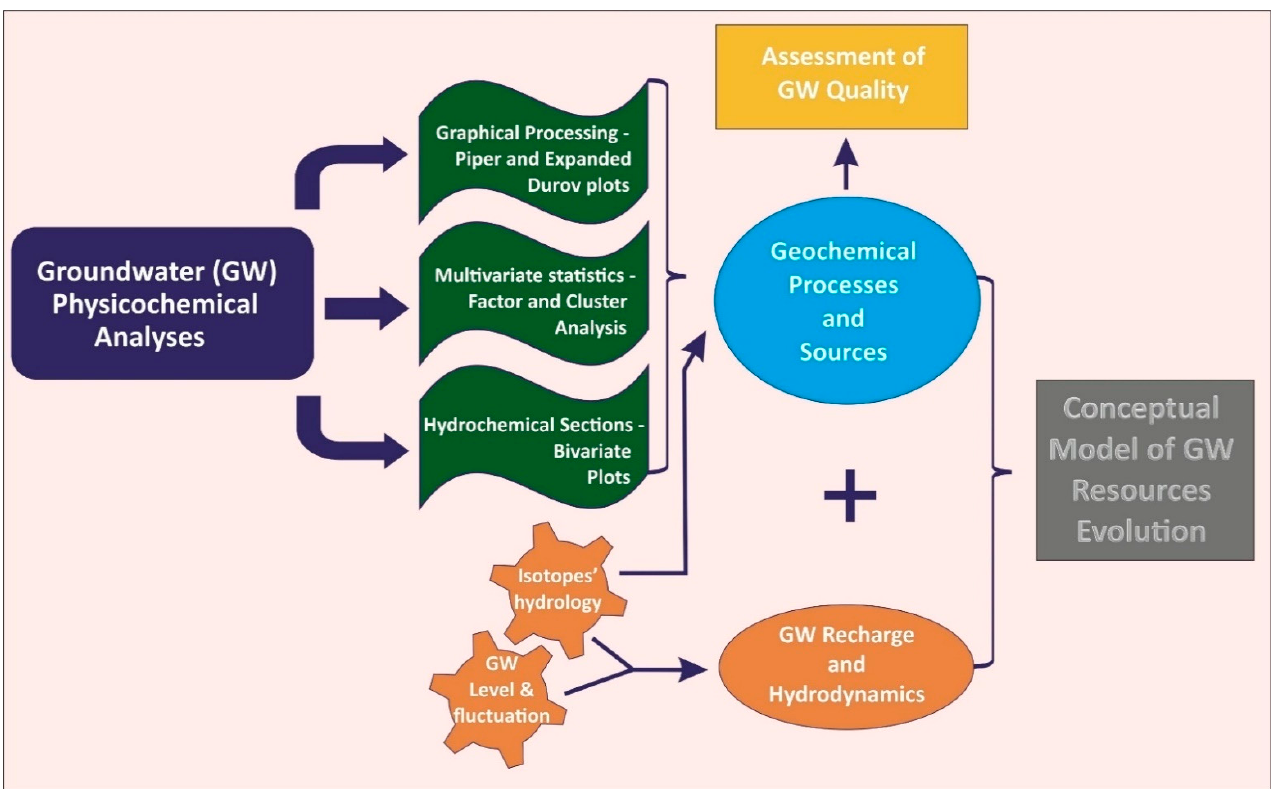
Figure 3. Methodological workflow for the development of groundwater resources conceptual model.